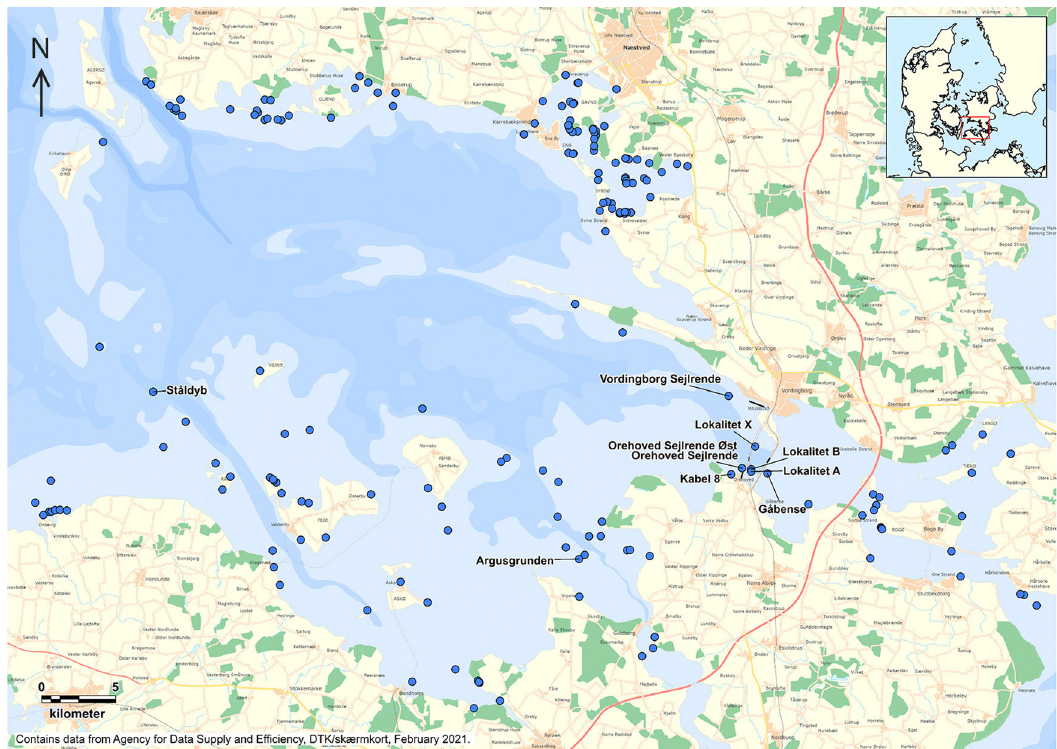
Figure 1: Map showing known sites and traces of Mesolithic activity in Smålandsfarvandet , south - eastern Denmark. Site information from Fund & Fortidsminder at